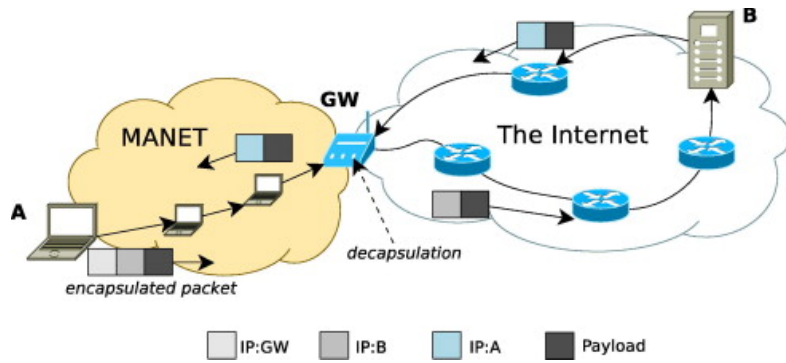
Figure 11. Robust and flexible internet connectivity for mobile ad hoc networks [50].